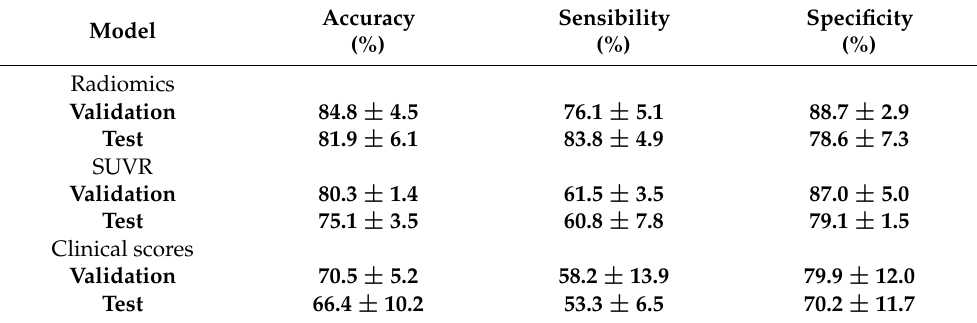
Table 2. The classification results for AD vs. NC